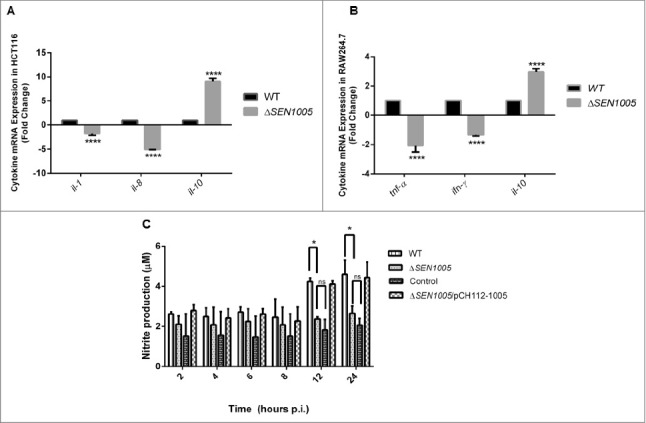
In vitro studies to show cytokine and nitric oxide production in epithelial and phagocytic cells after infection with WT and ΔSEN1005. (A) Expression profile of pro-inflammatory (IL-1 and IL-8) and anti-inflammatory (IL-10) cytokines in HCT116 by qRT-PCR. The data was presented corresponding to the fold-change differences in gene expression in ΔSEN1005 with respect to WT. (B) RAW264.7 expressing TNF-α and IFN-ϒ (pro-inflammatory) and IL-10 through qRT-PCR. The data was presented corresponding to the fold-change differences in gene expression in ΔSEN1005 with respect to WT. gapdh was considered as internal control. (C) Production of nitric oxide (nitrite) in RAW264.7 cells after infection with WT, ΔSEN1005 and ΔSEN1005/pCH112-1005 at indicated time points by Griess reaction. Results were shown from three independent experiments in triplicates and data represented as mean ± SD. Statistical significance: *P < 0.05, **P < 0.01, ***P < 0.001, ****P < 0.0001 (Two-way ANOVA).